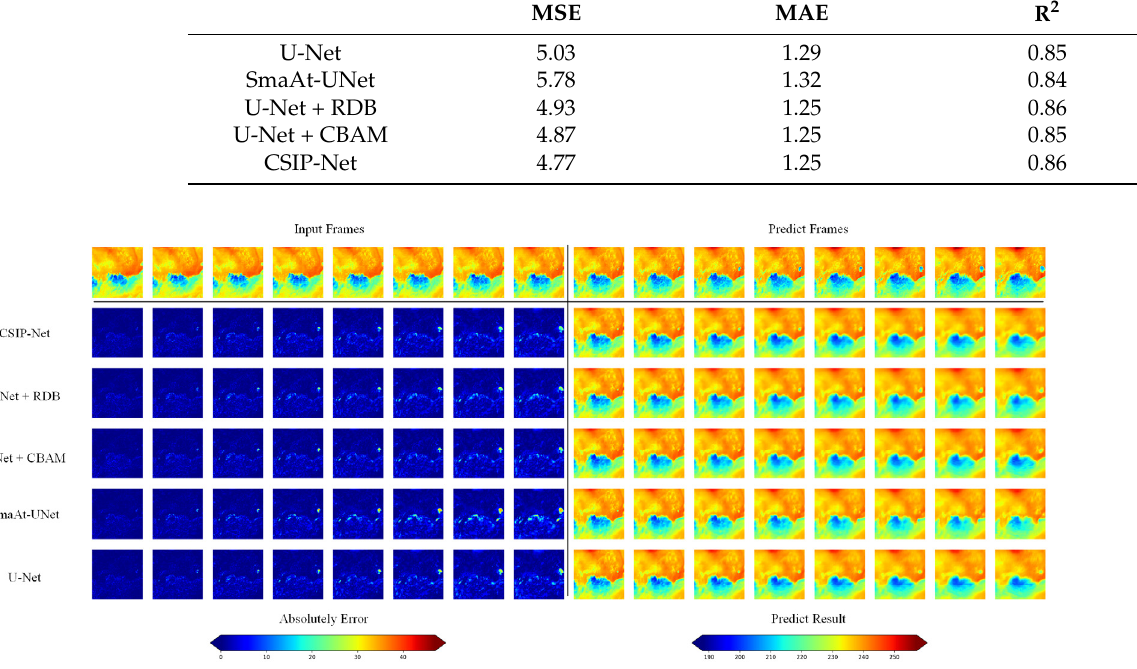
Figure 9. The time series comparison images of the prediction results of the four models